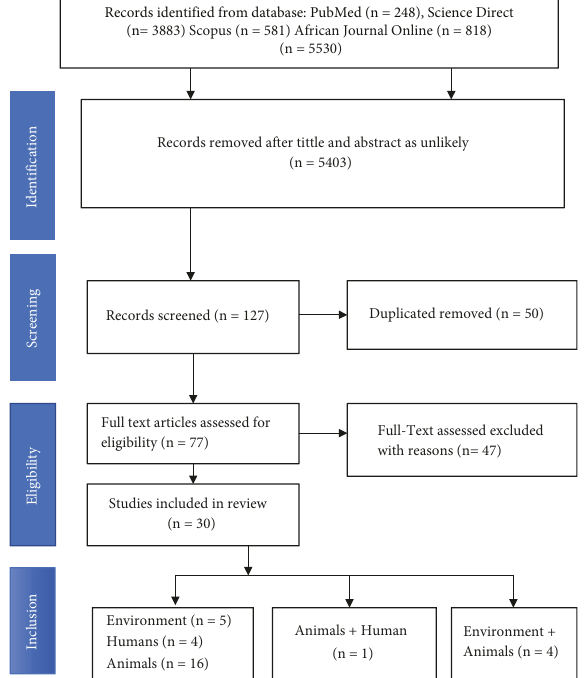
Figure 1: The PRISMA flowchart showing the selection processes of articles on prevalence of Salmonella serovars in South